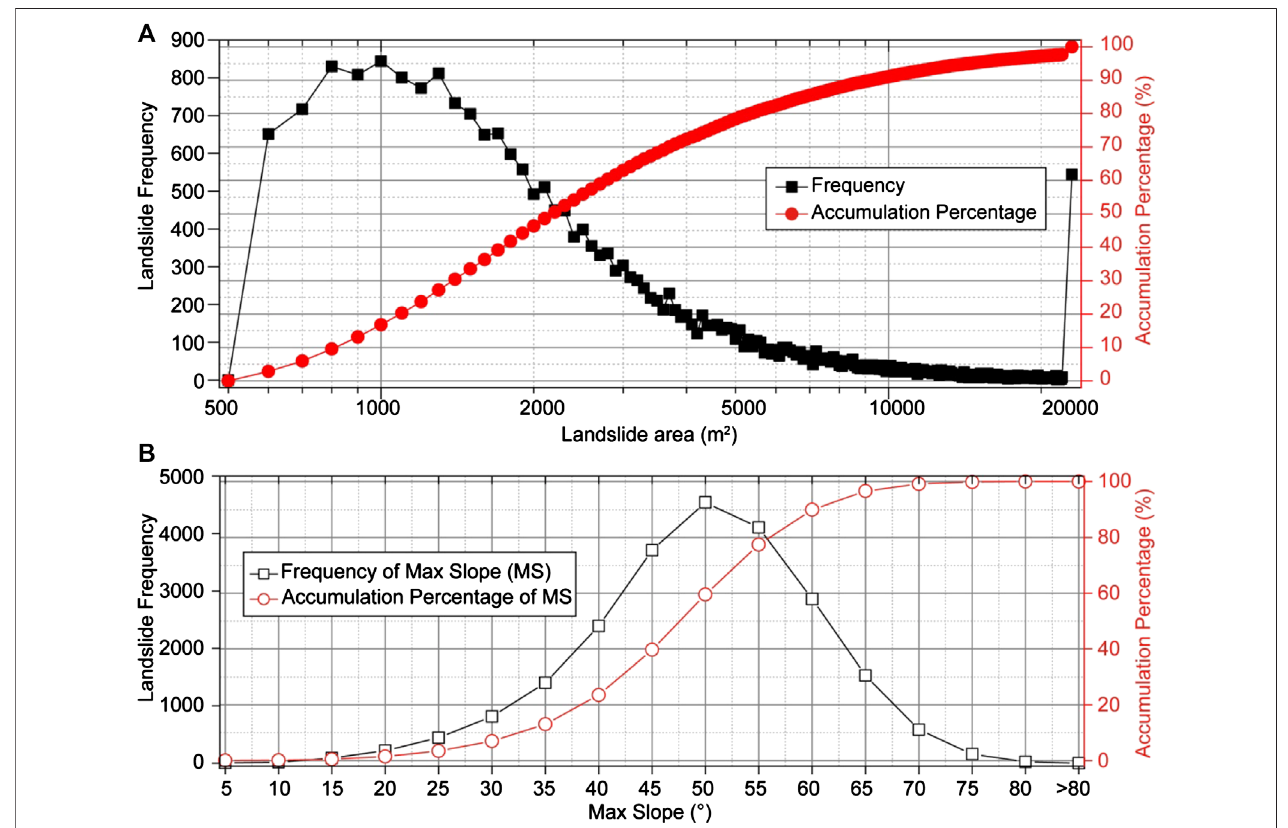
FIGURE 4 | Landslide area (A) and maximum slope (B) vs. number and accumulation percentage.